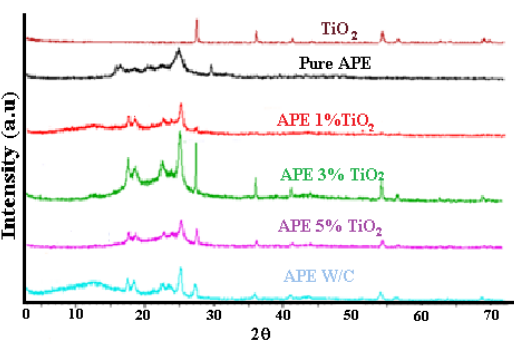
Fig. 2. XRD patterns of TiO nanocomposites with 1%, 3% and 5% TiO